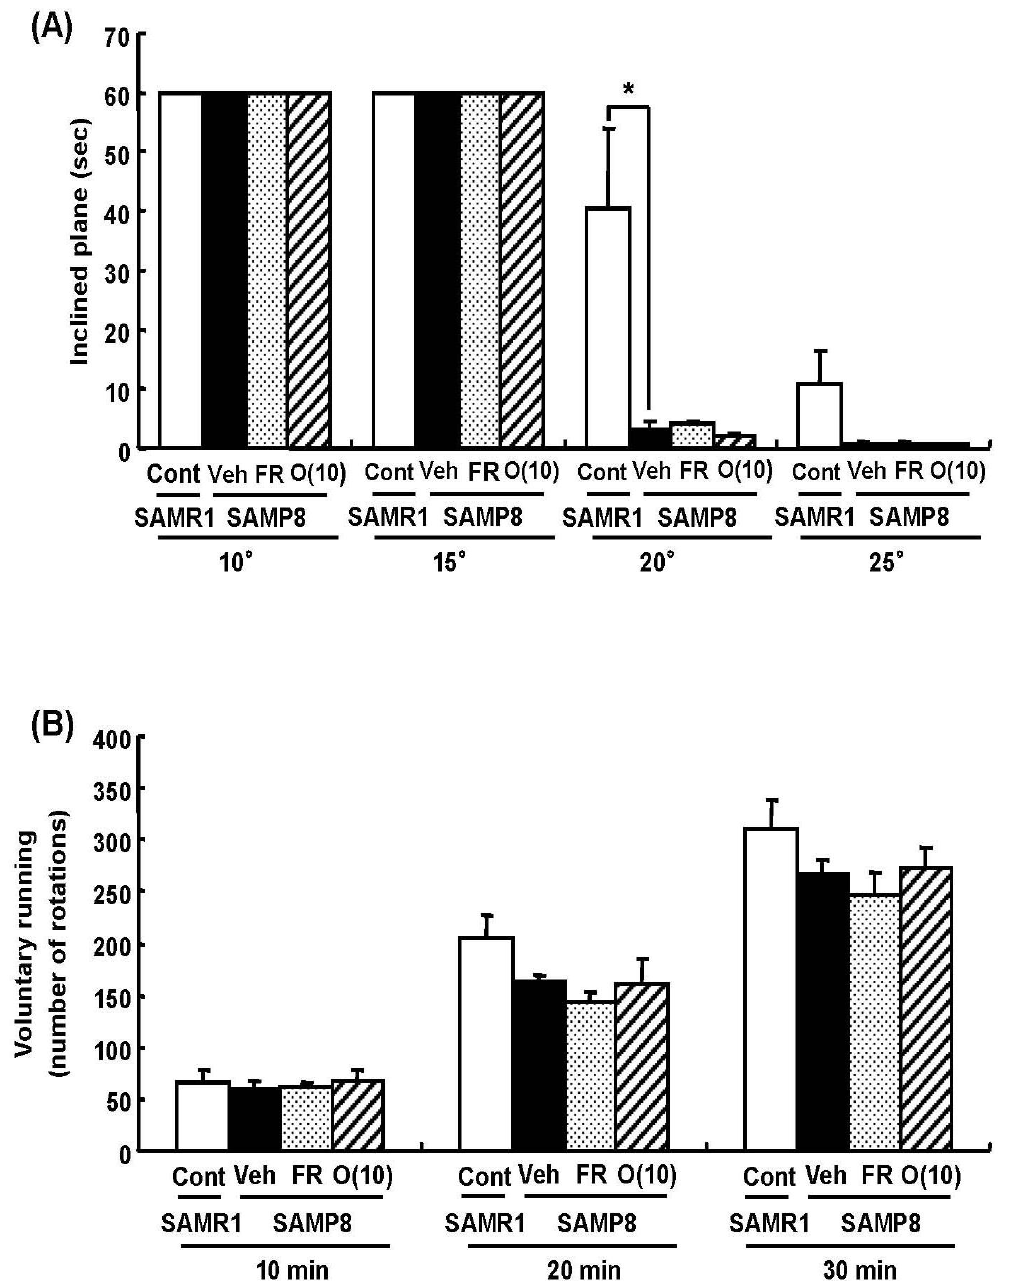
Figure 5. Effects of oligomers on motor function. Forty-five or six-week-old SAMP8 mice were administered vehicle (Veh, water p.o., n = 4), while another two groups were administered oligomers orally at doses of 10 mg/kg body weight/day (O (10), n = 4) using a stomach tube until death. For the remaining group of mice, the mean food intake was restricted to 60% until death (FR, n = 4). SAMR1 mice (Cont, 45-46 weeks old, n = 4) were used as a control group. One hundred and thirty-nine days after the start of administration, the time spent on the inclined surface without dropping was measured ( A ). The number of rotations measured for 30 min ( B ). Administration was continued during the tests. a p = 0.0159 (A: Student’s t